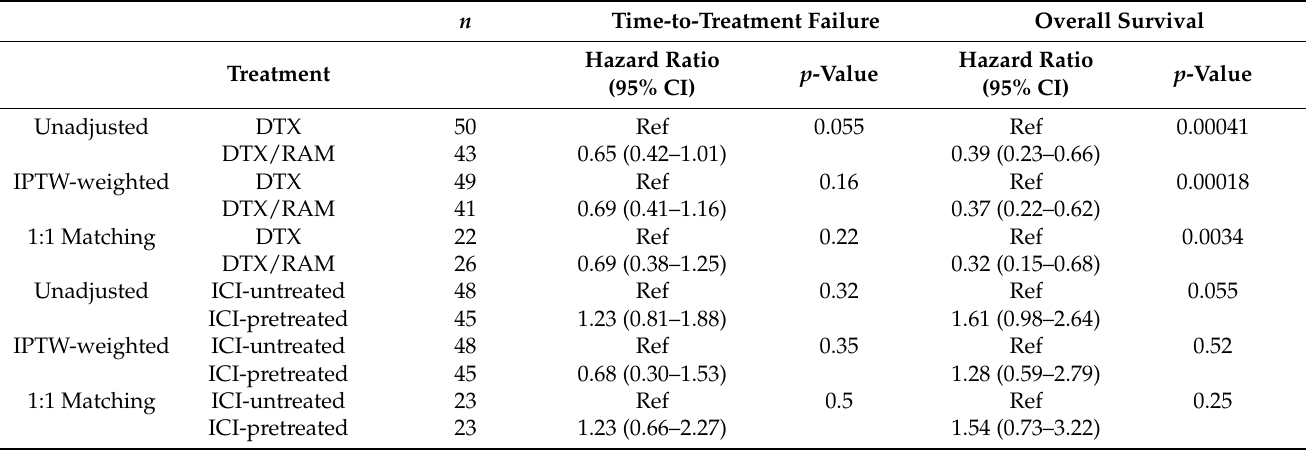
Table 4. Hazard ratio adjusted by propensity